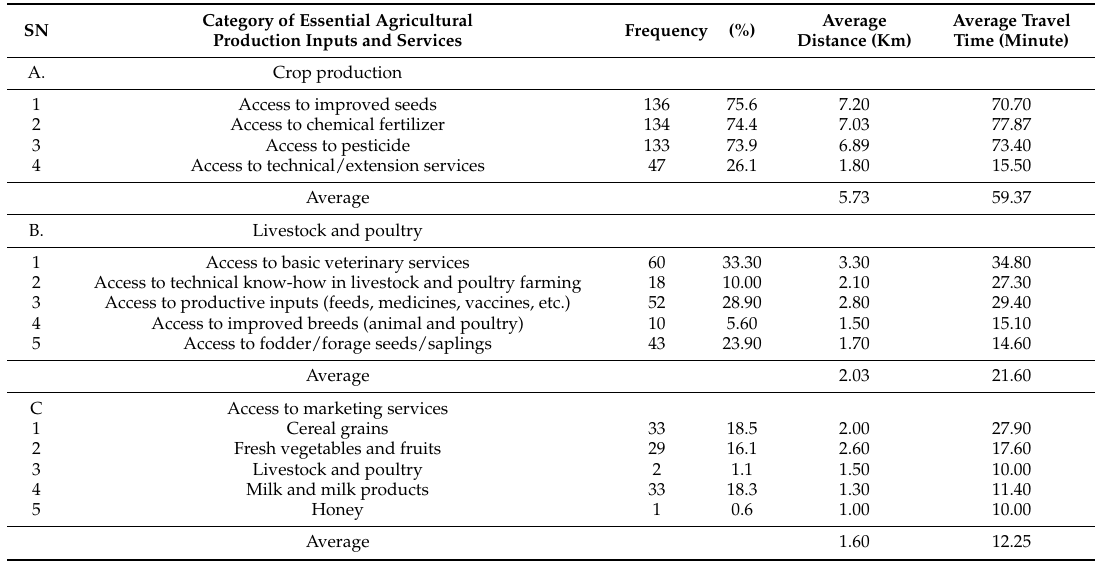
Table 14. Field survey data on access to external inputs and services for crop production in the study area.